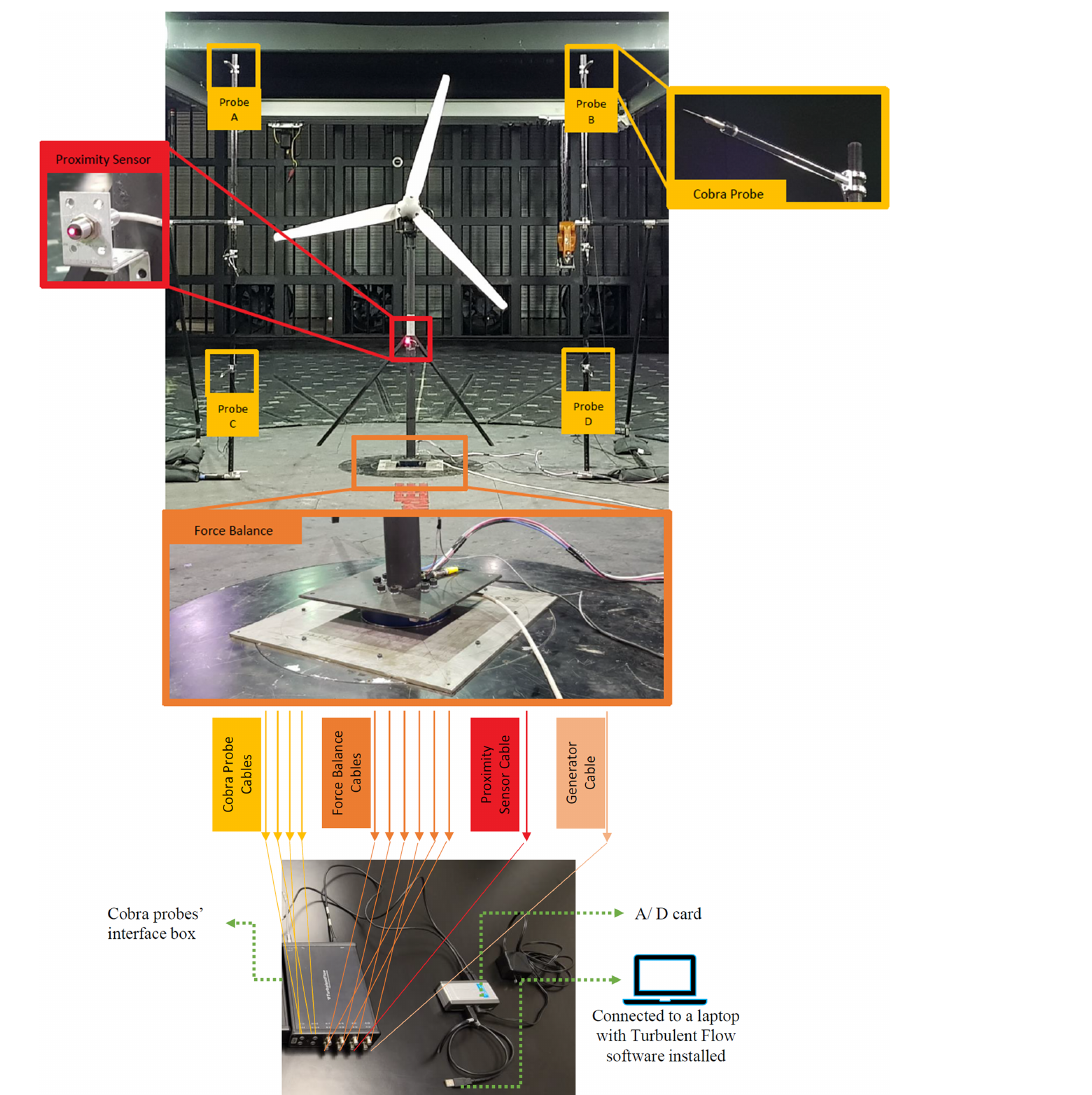
Figure 3. Setup for measuring power performance and dynamic loads for different types of inflow.